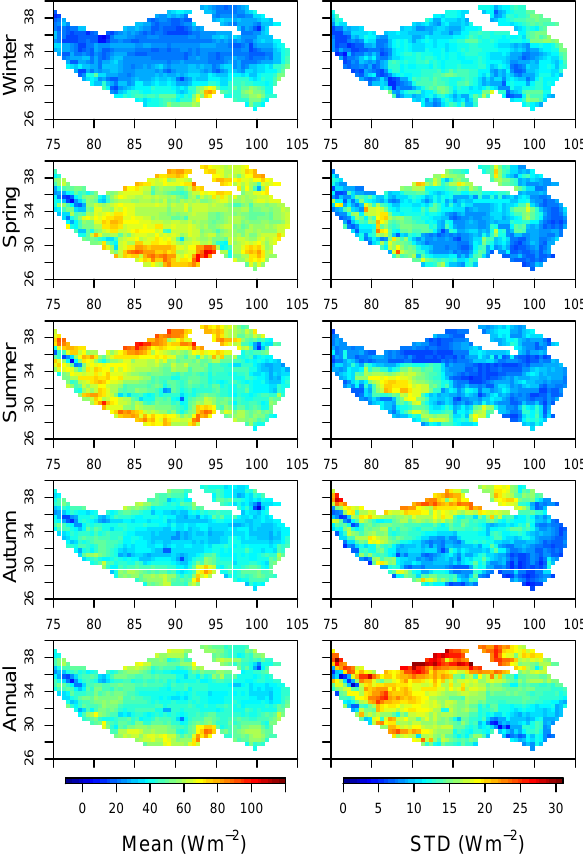
Figure 8. Spatial distribution of seasonal/annual mean and STD of the fused sensible heat flux over the TP